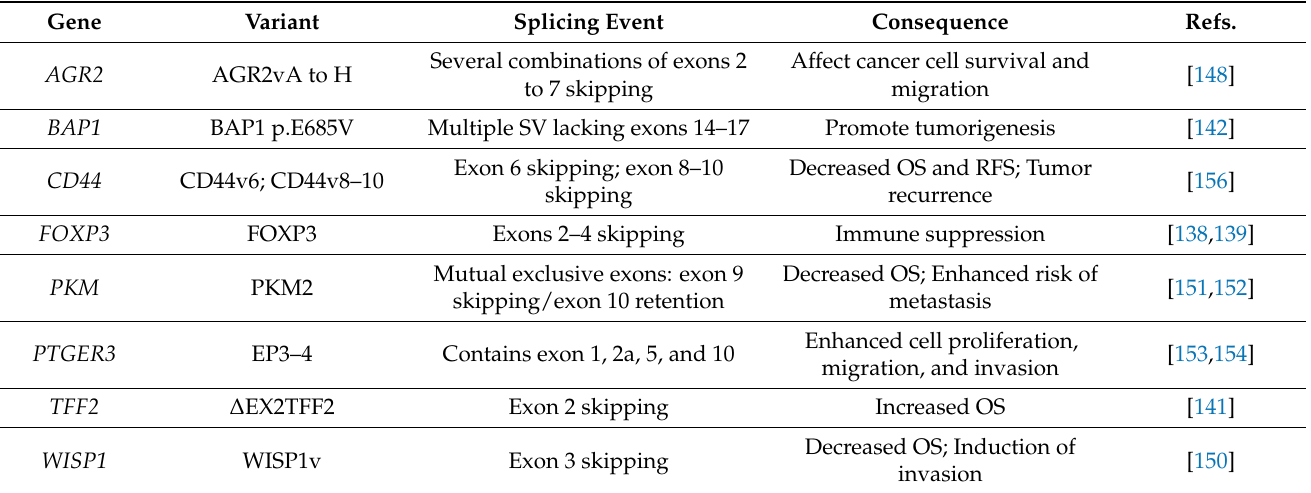
Table 3. Alternative splicing of genes involved in intrahepatic cholangiocarcinoma development and